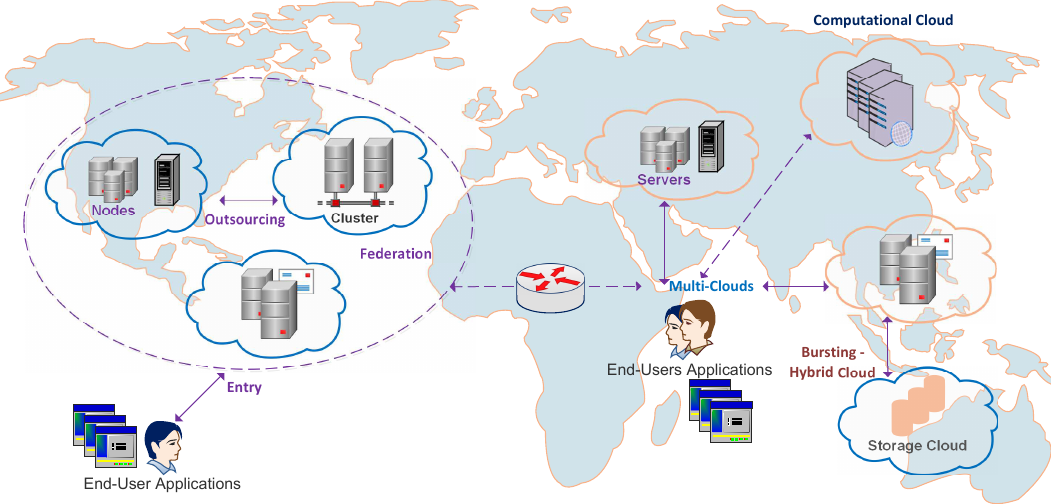
Figure 1. Interconnected cloud